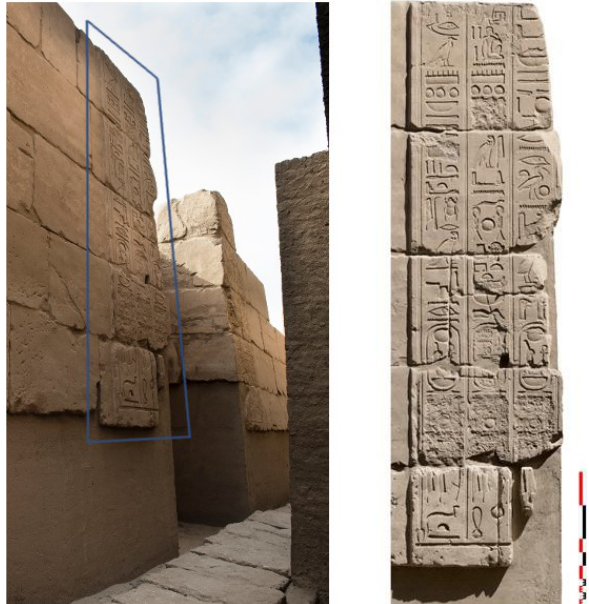
Figure 1: On the left, general view of the inscriptions to study (inside the blue frame). On the right, result of the image stitching after